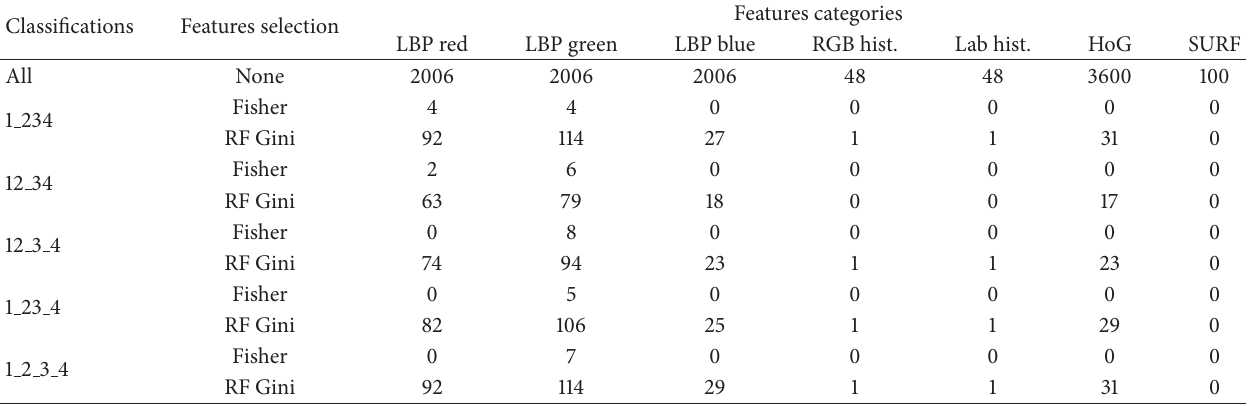
Table 2: Number of selected features per category.